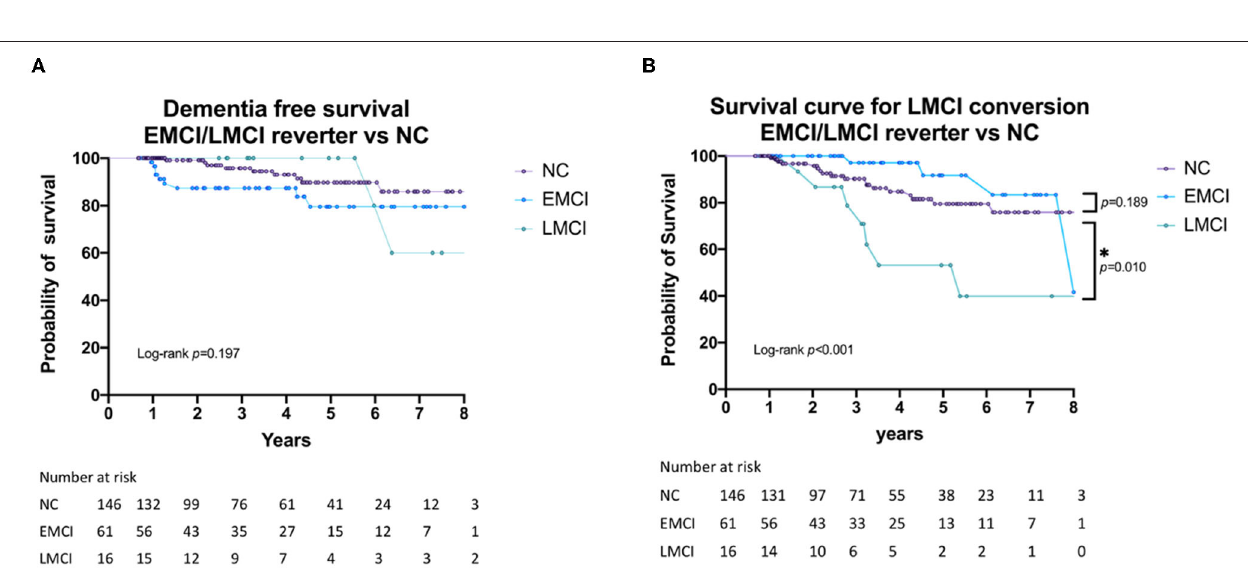
FIGURE 2 | (A) Dementia-free survival of EMCI/LMCI who underwent reversion to normal cognitive status compared with that for normal controls. (B) LMCI-free survival of EMCI/LMCI who underwent revision to normal cognitive status compared with that for the NC group. NC, normal cognition; EMCI, early mild cognitive impairment; LMCI, late mild cognitive impairment. *: p <